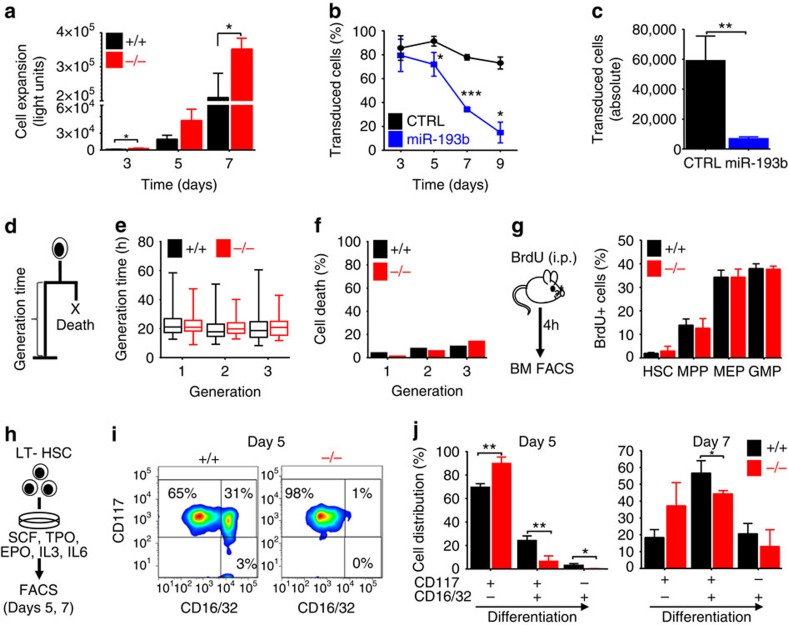
MiR-193b controls HSPC expansion by altering differentiation and not by influencing cell cycle or survival.(a) Proliferation assay of sorted LT-HSCs in serum-free liquid culture (SCF, TPO, IL3, IL6 and EPO). N=3 independent experiments. (b,c) Lentiviral transduction of LT-HSCs with miR-193b or CTRL vectors and cell culture (SCF, TPO). N=3 independent experiments. (b) The percentage of transduced cells was determined via FACS. (c) Absolute number of cells after 9 days in culture. (d) Generation time and cell death determined using video-microscopy-based cell tracking. (e) Generation times in subsequent generations of LT-HSCs determined via single-cell tracking. (f) Cell death events assessed via single-cell tracking. (g) BM FACS analysis of BrdU incorporation in HSPC populations after 4 h of in vivo BrdU pulse. N=3 mice per genotype. (h) Experimental scheme for the in vitro differentiation assay. (i) Exemplary FACS plots of CD16/32/CD117 expression at day 5 of differentiation. (j) Cell distributions at days 5 and 7 determined according to their CD117 and CD16/32 expression. N=3 individual mice per genotype. All data are represented as the mean±s.d. *P<0.05; **P<0.01 and ***P<0.001.